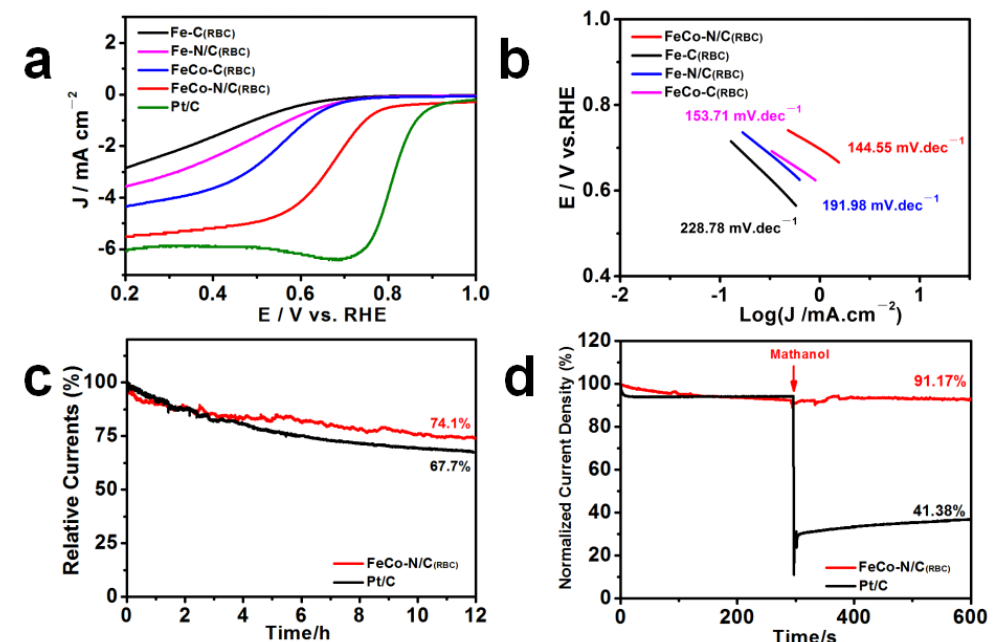
Figure 6. ( a ) LSV curves for ORR at 1600 rpm with a scanning rate of 5 mV·s − 1 in O 2 saturated 0.1 M HClO 4 solution. ( b ) Tafel plots for ORR in 0.1 M HClO 4 solution. ( c ) i − t chronoamperometric responses of FeCo-N/C (RBC) and 20 wt% commercial Pt/C at 0.78 V in O 2 -saturated 0.1 M HClO 4. ( d ) i − t chronoamperometric responses of FeCo-N/C (RBC) and 20 wt% commercial Pt/C electrodes upon the addition of 3 M methanol in 0.1 M HClO 4 .